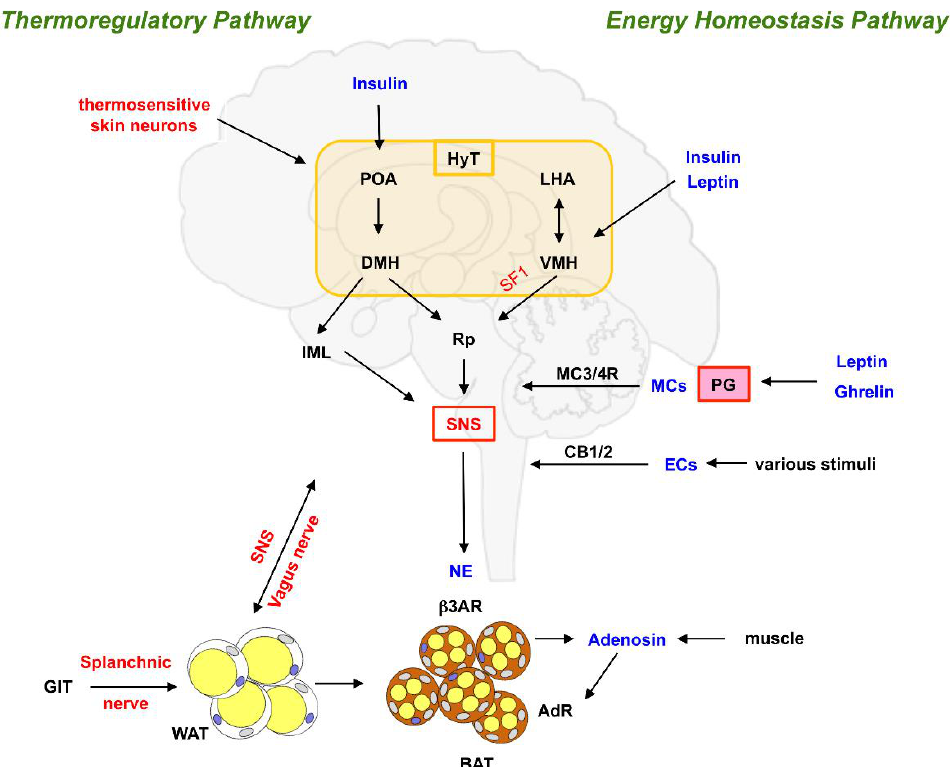
Figure 3. Neural circuitry controlling BAT activity. Major neuronal signaling routes are displayed in red, and molecules exerting signaling effects are shown in blue. β 3AR, β 3 adrenergic receptor; AdR, adenosine receptor(s); BAT, brown adipose tissue; DMH, dorsomedial hypothalamus; ECs, Endocannabinoids; GIT, gastrointestinal tract; HyT, hypothalamus; IML, intermediolateral nucleus; LHA, lateral hypothalamic area; MCs, Melanocortins; NE, norepinephrine; PG, pituitary gland; POA, preoptic area; Rp, Raphe pallidus; SNS, sympathetic nervous system; VMH, ventromedial hypothalamus; WAT, white adipose tissue.